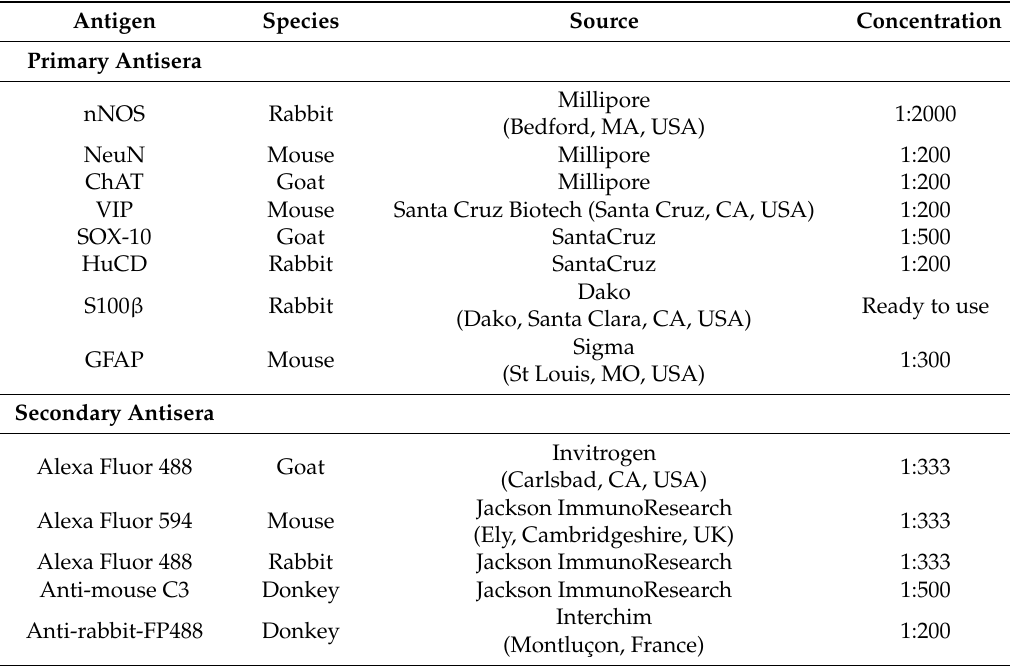
Table 1. Primary and secondary antisera used in immunohistochemistry. Source